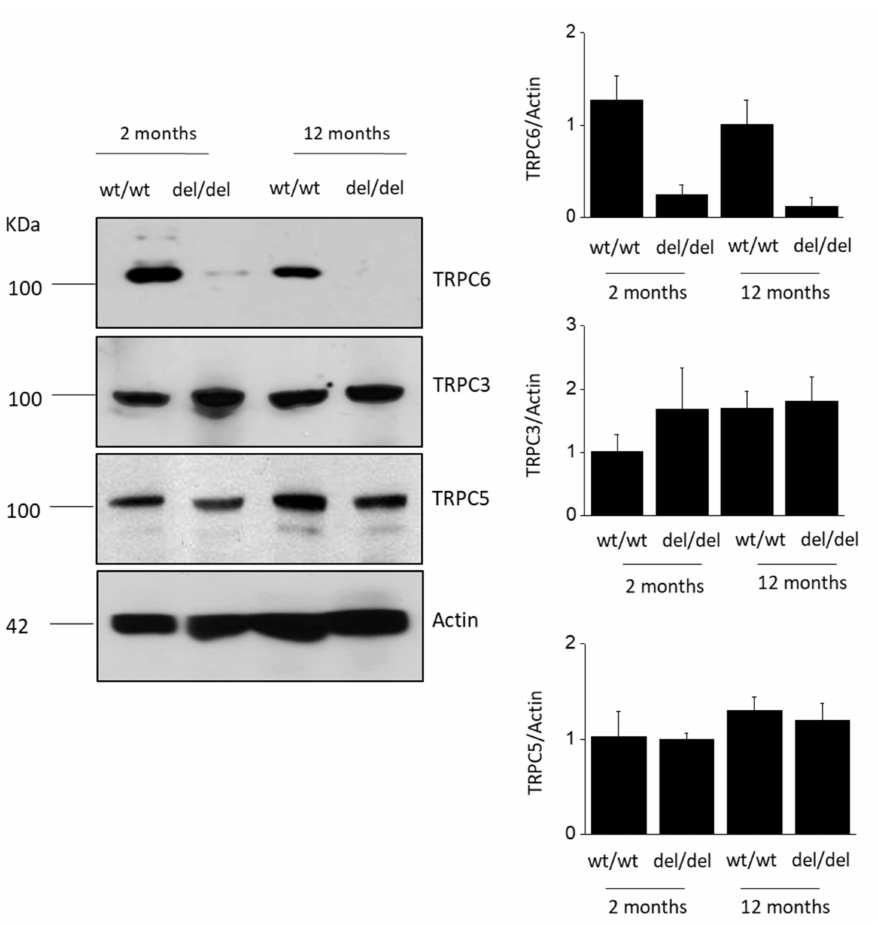
Figure 1. Immunoblot analysis of TRPC6, TRPC3 and TRPC5 abundance from renal cortex of Trpc6 wt/wt and Trpc6 del/del rats at 2 and 12 months of age as indicated. Representative blots are shown to the left. Bar graphs to the right denote mean ± SD of densitometric analyses with three animals in each